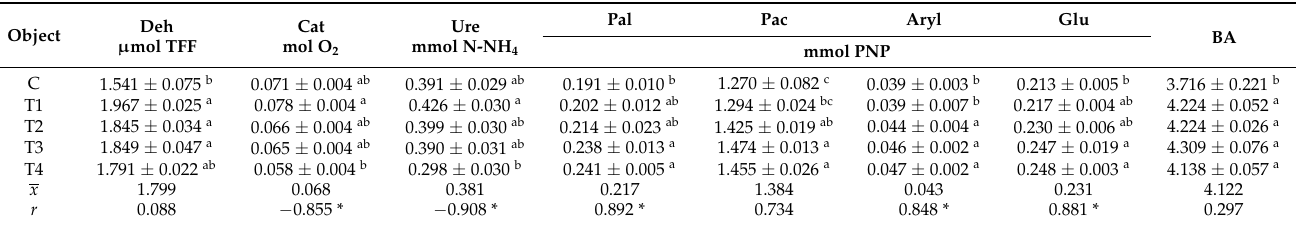
Table 3. Effect of tebuconazole on the activity of soil enzymes in 1 kg soil